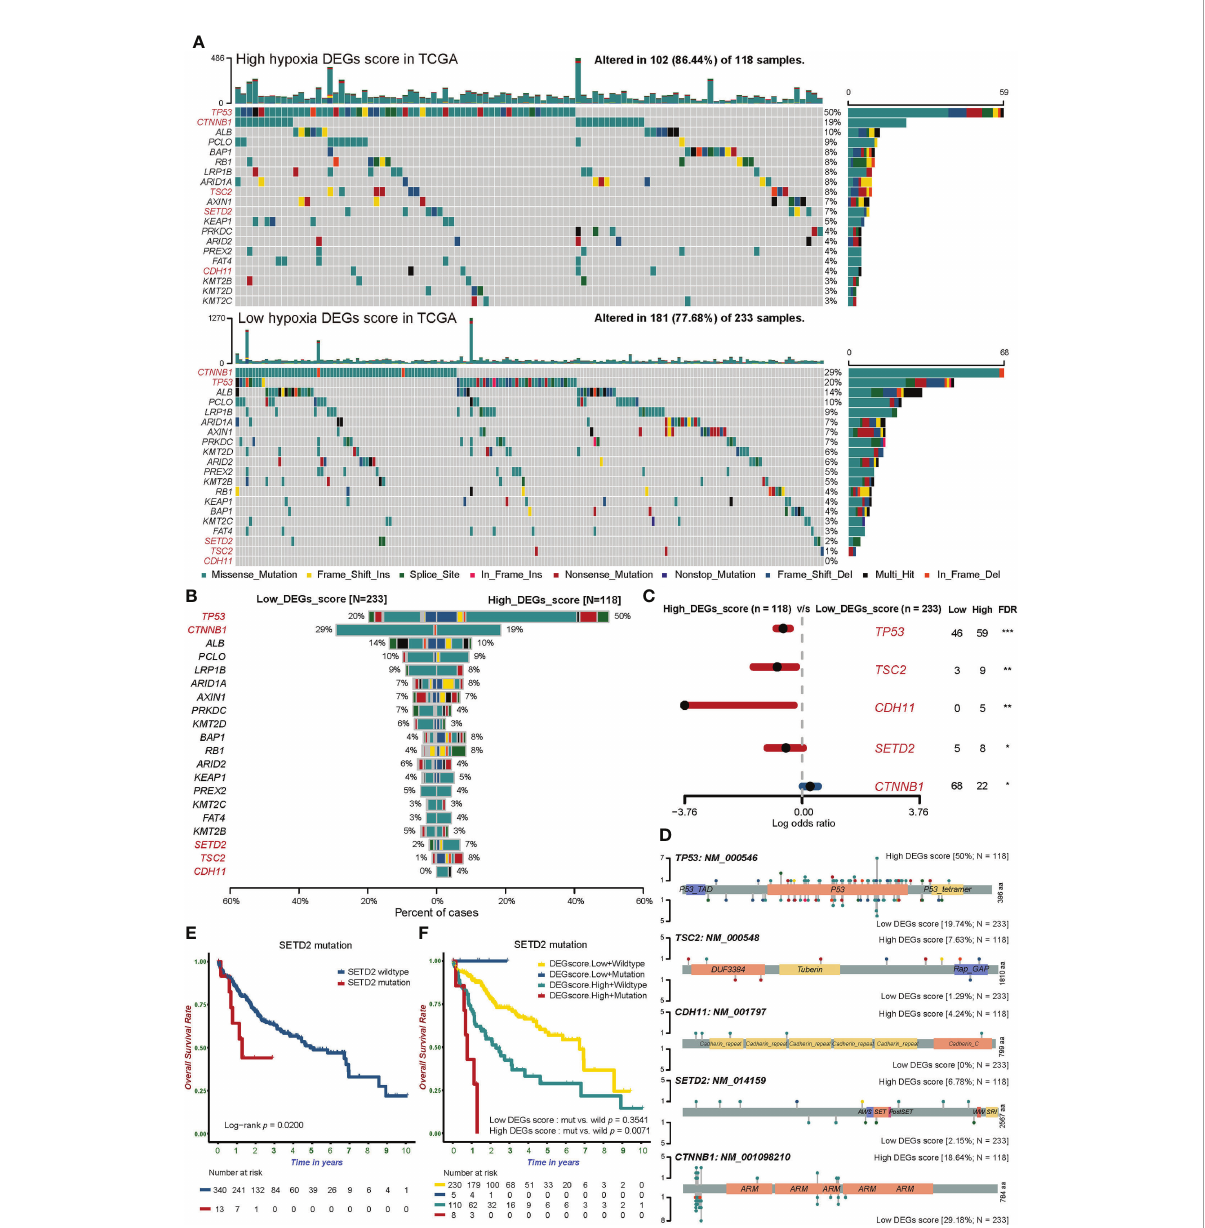
FIGURE 5 The somatic mutation landscape of tumor-associated genes in groups with different hypoxic statuses. (A) Waterfall plots showing the distribution of mutation among the top 20 most frequently mutated tumor-associated genes in the two Hypoxia_DEGs_Score groups from the TCGA-LIHC cohort. Each column represents an individual patient. The upper bar graph shows TMB; the number on the right indicates the mutation frequency in each tumor-associated mutated gene. The right bar graph shows the proportion of each variant type. Mutation types are indicated in the legend at the bottom. (B) The bar plot compares mutation rates for tumor-associated mutated genes in the two Hypoxia_DEGs_Score groups. (C) Forest plot showing the top 5 most signi fi cantly differentially mutated genes between the two groups. The Fisher test was used to determine the statistical signi fi cance of the differences. P values were corrected using the Benjamini-Hochberg method. *FDR < 0.05. **FDR < 0.01. ***FDR < 0.001 (D) Lollipop plots showing the amino acid residues corresponding to the mutated sites of the top 5 mutated genes. (E) Kaplan-Meier survival curves showing differences in overall survival between patients with wild-type or mutant SETD2 in the TCGA-LIHC cohort. (F) Kaplan-Meier survival curves demonstrating distinctions in overall survival strati fi ed by both Hypoxia_DEGs_Score grouping and SETD2 mutation status in the TCGA-LIHC cohort. Mut, mutant SETD2; WT, wild-type